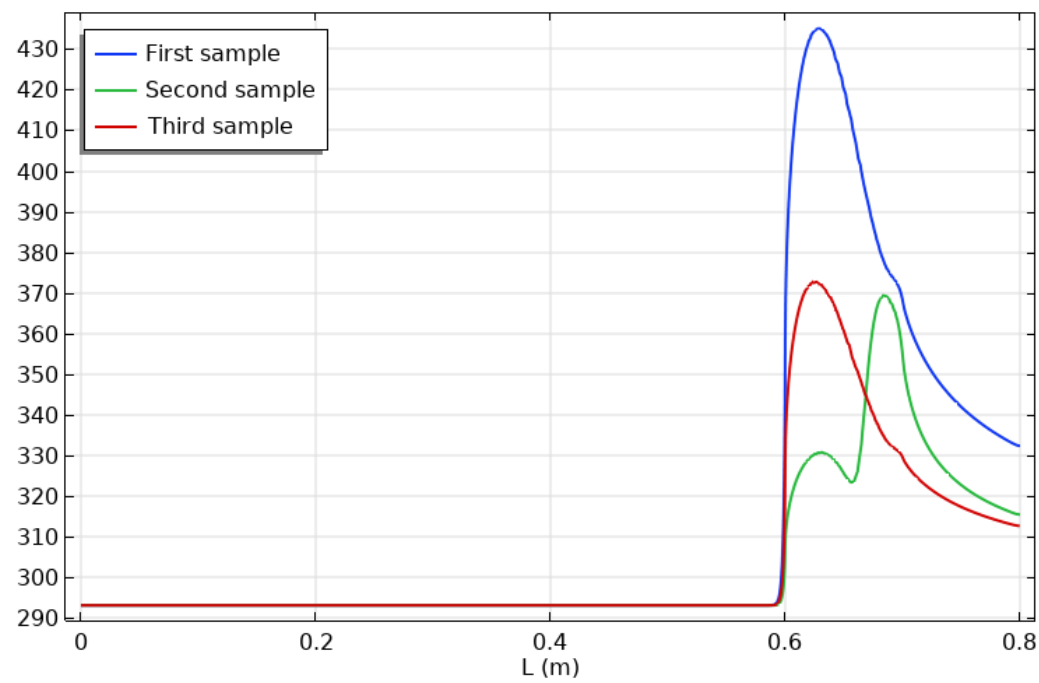
Figure 16. Local temperature in the channel–enclosure assembly .